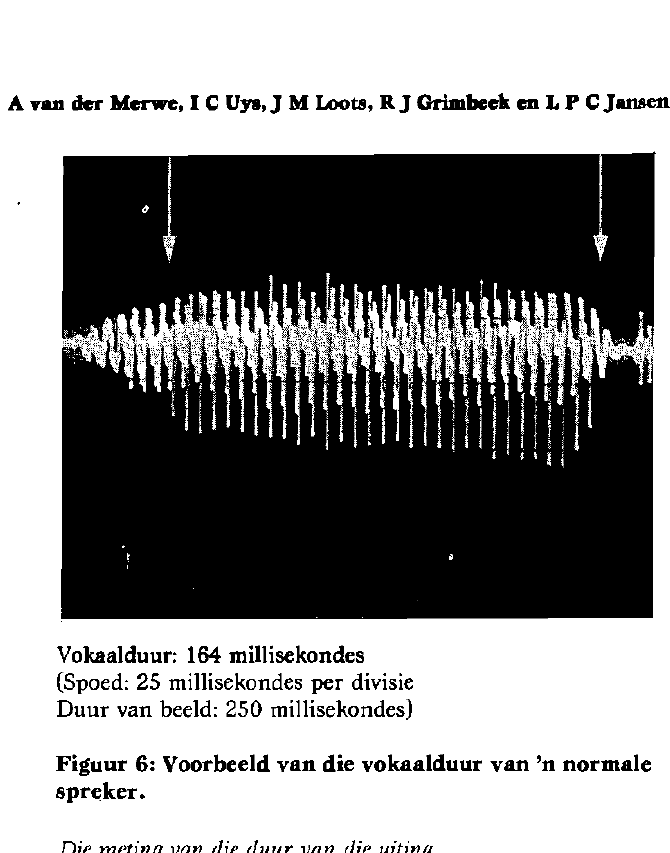
Figuur 4: Voorbeeld van 'n negatiewe stemaanvangstyd wat byna buite die normale perke val by 'n verbaal aprak- tiese spreker.